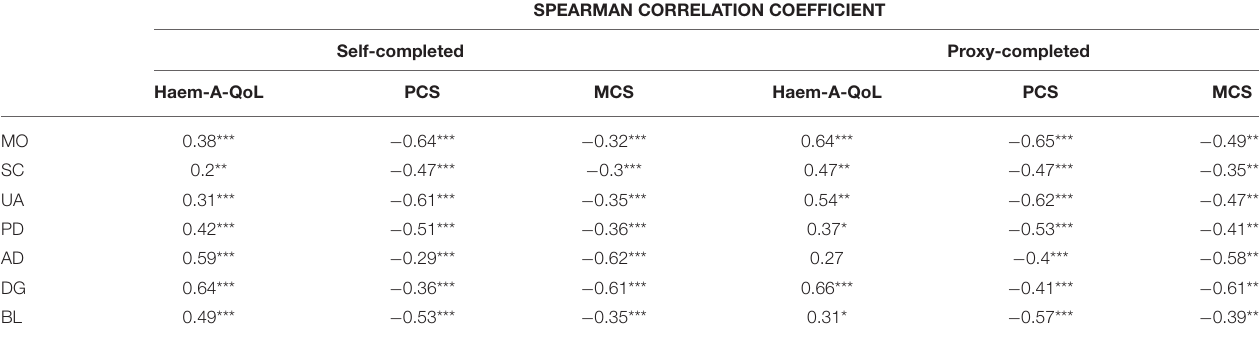
TABLE 3 | Correlation between EQ-5D-5L, bolt-on items and the Haem-A-QoL and the SF-12. SPEARMAN CORRELATION COEFFICIENT Self-completed Proxy-completed